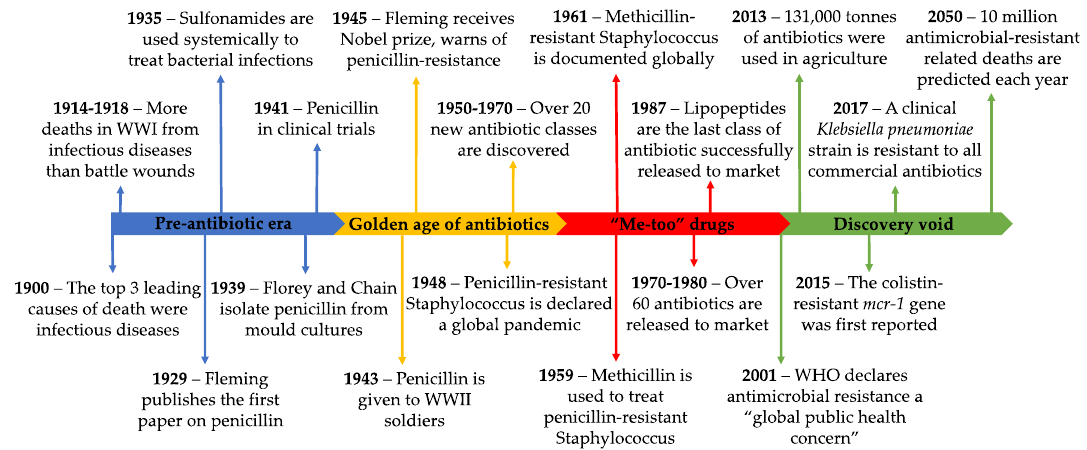
Figure 1. A summary of events in the antibiotic-resistance timeline. WHO, World Health Organization; WWI/II, World War I/II.